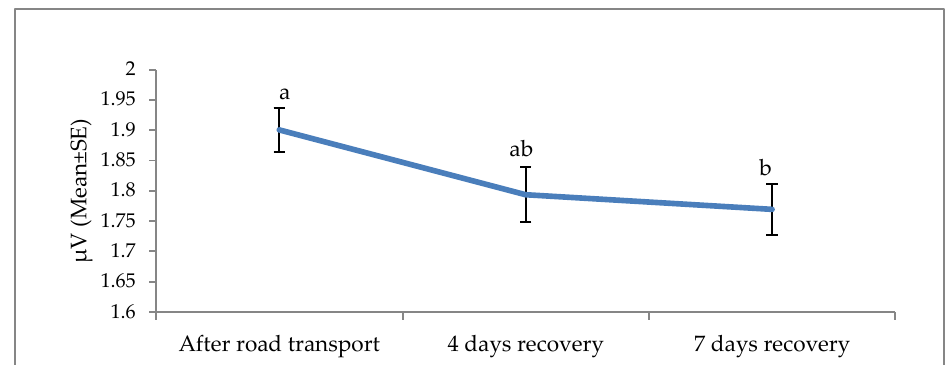
Figure 6. Effects of road transport on the delta root mean square (RMS) in cattle. The number of animals used in each sampling point was 24 heifers. Means with different letters are significantly different at p < 0.05.